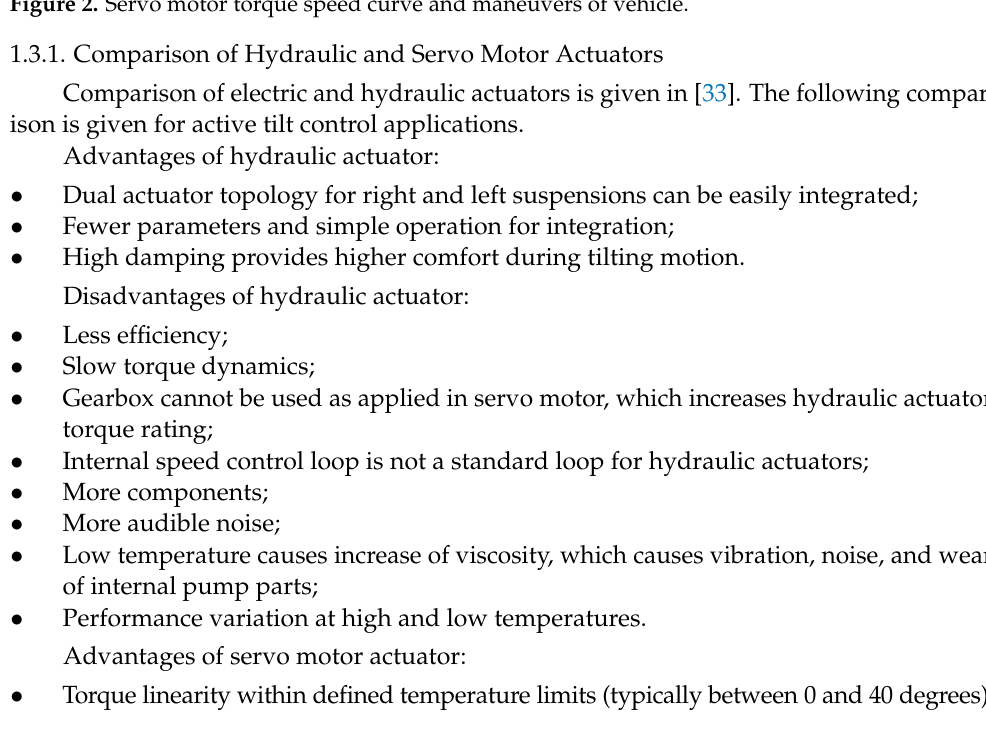
Figure 2. Servo motor torque speed curve and maneuvers of vehicle.